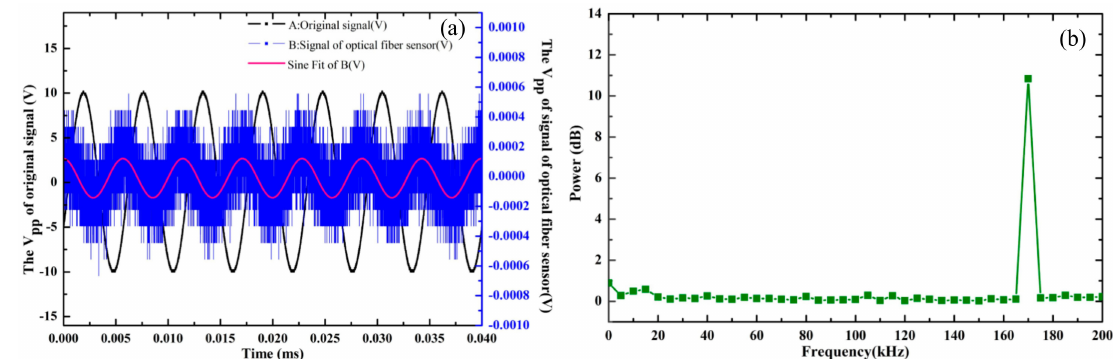
Figure 8. ( a ) The exciting, detected and fitted ultrasonic signals at 175 kHz; ( b ) the frequency spectrum of ultrasonic signals at 175 kHz.